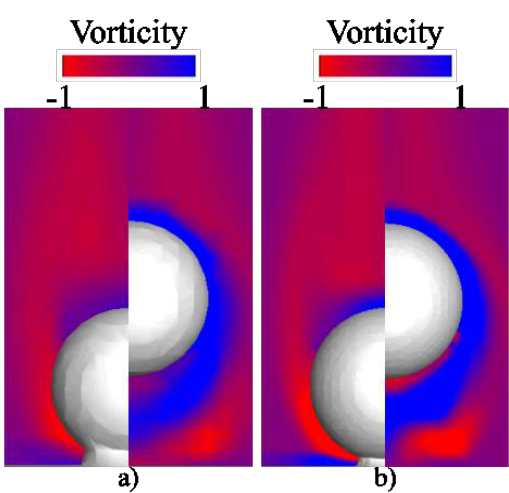
Figure 11. Vorticity distributions, at the collision of the particle with the wall ( a ) and at the rebound of the particle ( b ): ( a ) coarse mesh, ( b ) fine mesh.